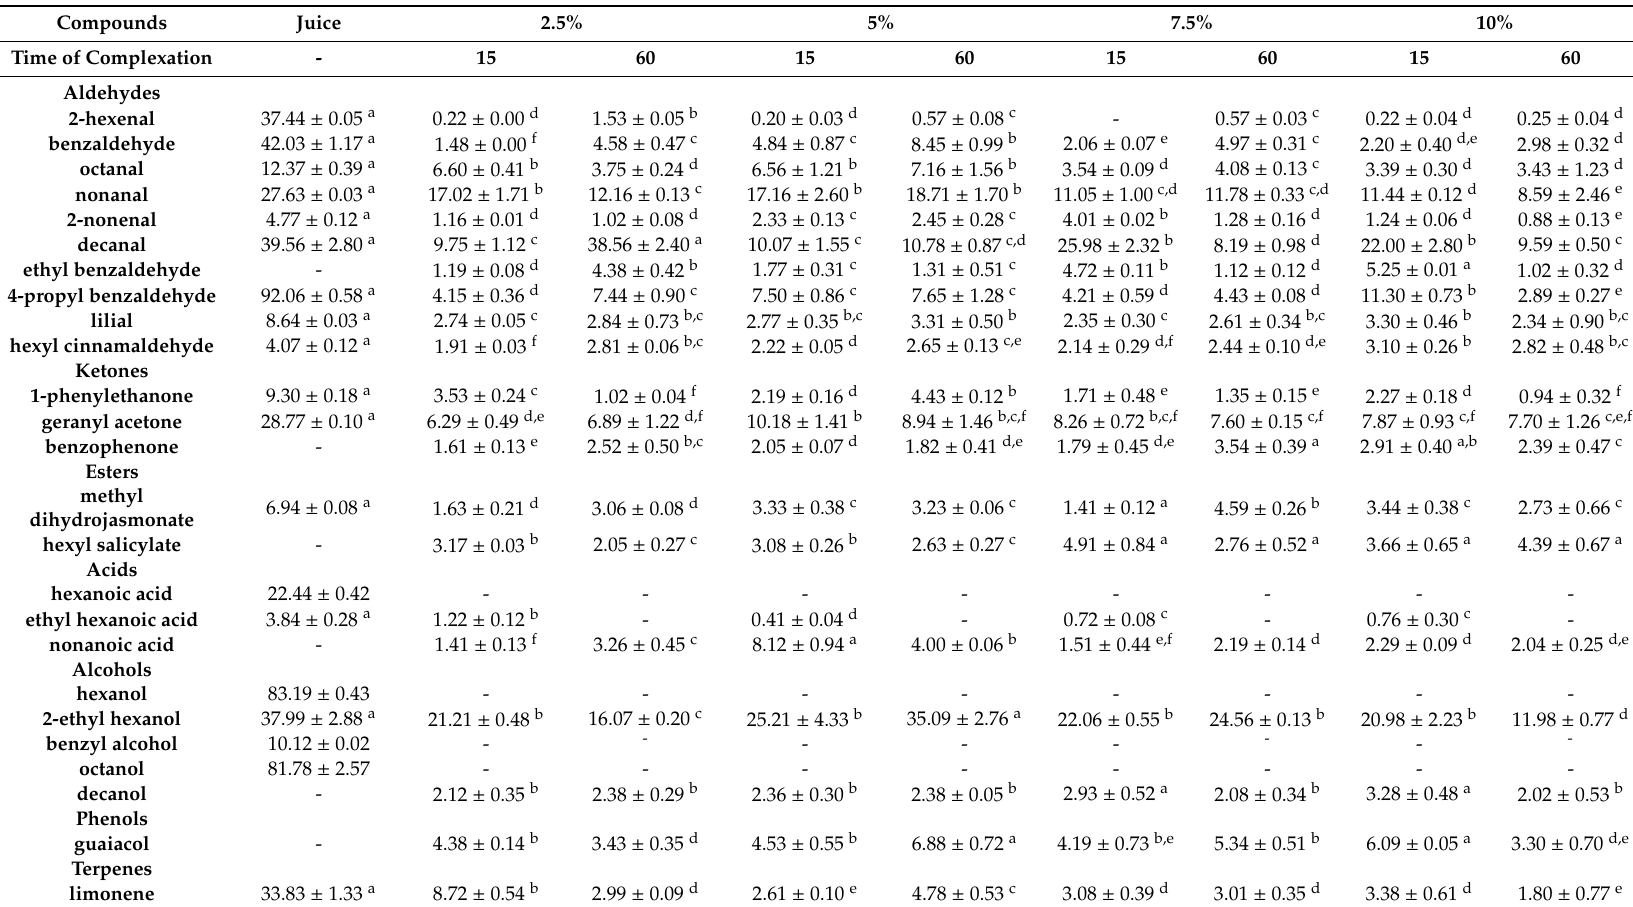
Table 2. Volatile compounds ( µ g / kg) of juice and cellulose / raspberry complexes prepared by 15 min and 60 min of complexation (2.5%, 5%, 7.5% and 10%—amounts of used